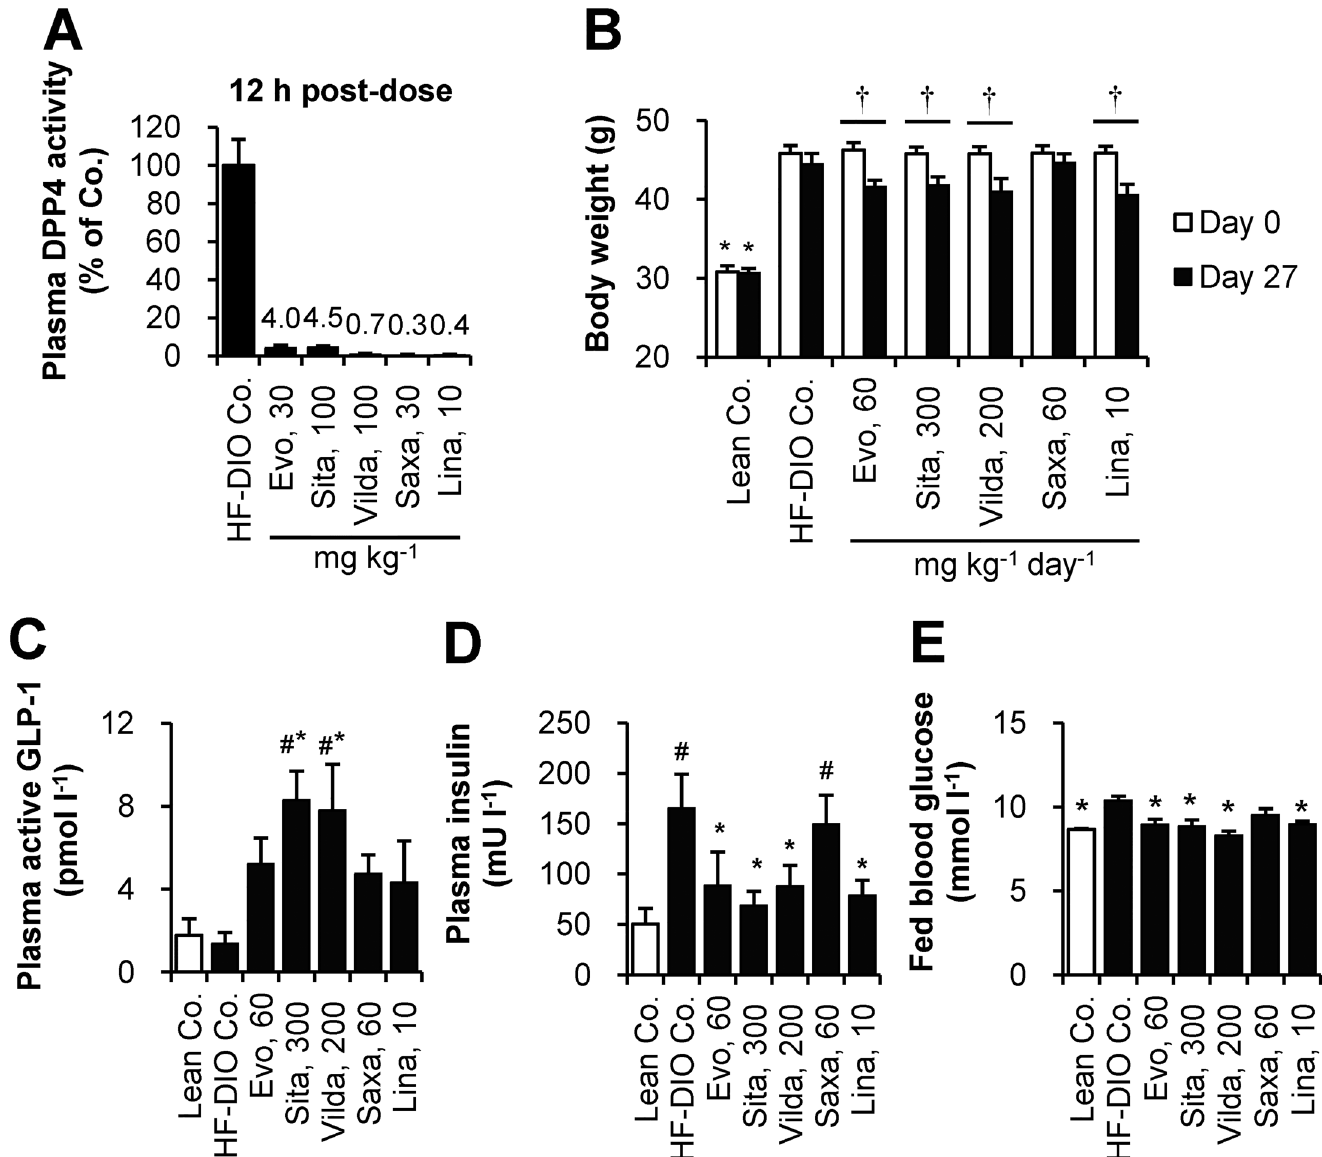
Fig 1. Body weight-loss effect of DPP4 inhibitors in established obese mice after 4-week treatment. (A) To select each dosage for twice daily administration, plasma DPP4 inhibition was assessed 12 h after a single oral administration in HF-DIO mice. (B-E) After 4 week-administration of evogliptin, sitagliptin, vildagliptin, saxagliptin, or linagliptin twice daily by oral gavage in HF-DIO mice, (B) body weight, (C) fed plasma levels of active GLP-1, (D) insulin, and (E) fed blood glucose levels were determined (n = 5/group). #, P < 0.05 vs. lean control; * , P < 0.05 vs. HF-DIO control by one-way ANOVA; † , P < 0.05 vs. the baseline by RM two-way